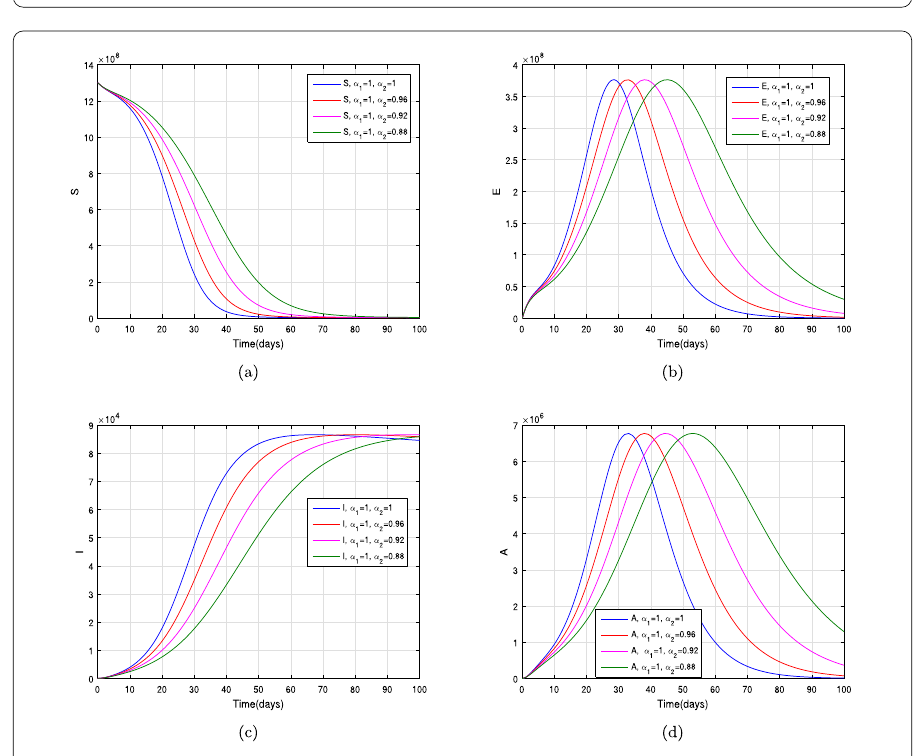
Figure 11 The dynamics of the model variables for α 2 = 1,0.96,0.92,0.88 and α 1 = 1, subfigures (a)–(d) respectively represent the susceptible, exposed, infected, and asymptomatic